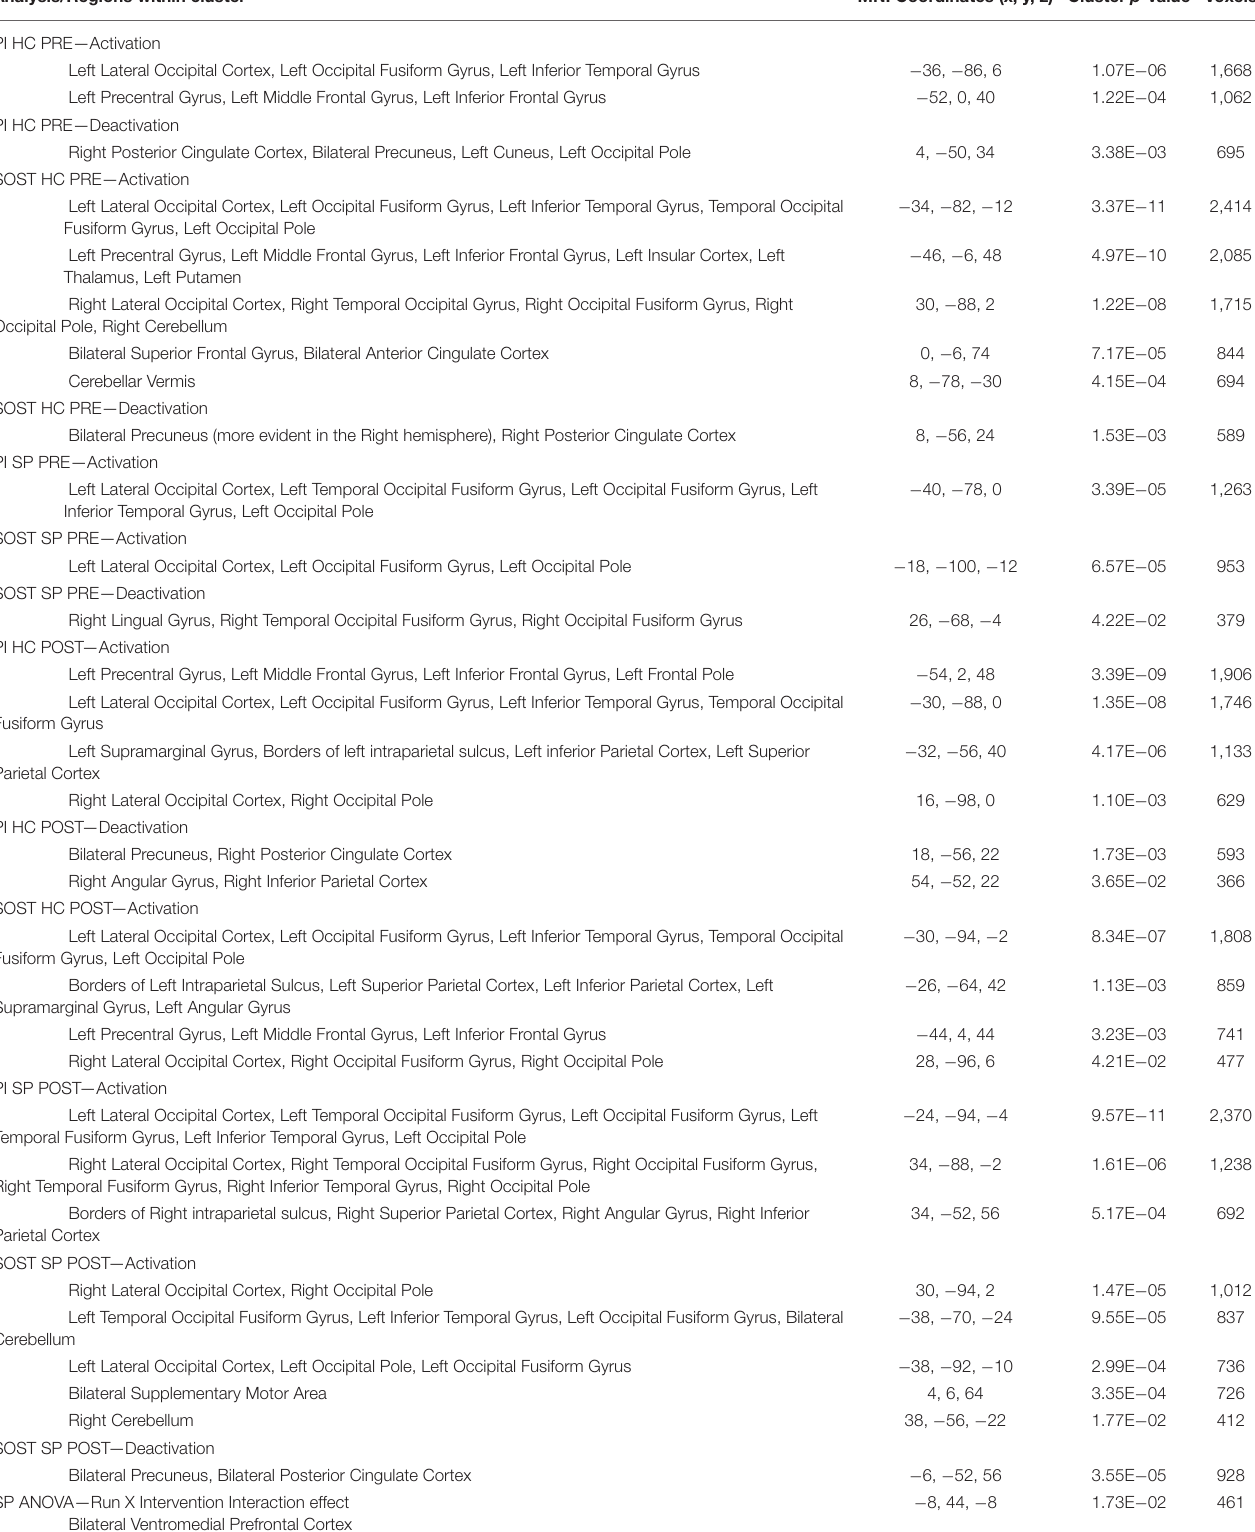
TABLE 2 | Description of clusters found in fMRI analyses. Analysis/Regions within cluster MNI Coordinates (x, y, z) Cluster p -value Voxels